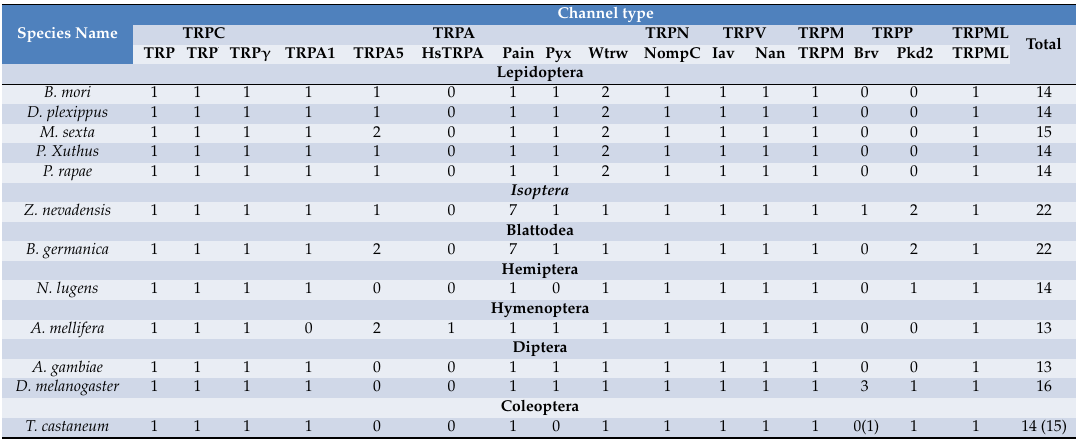
Table 2. Number of TRP channels identified in P. rapae , P. Xuthus , D. plexippus , M. sexta , Z. nevadensis , B. germanica , N. lugens and previous reports